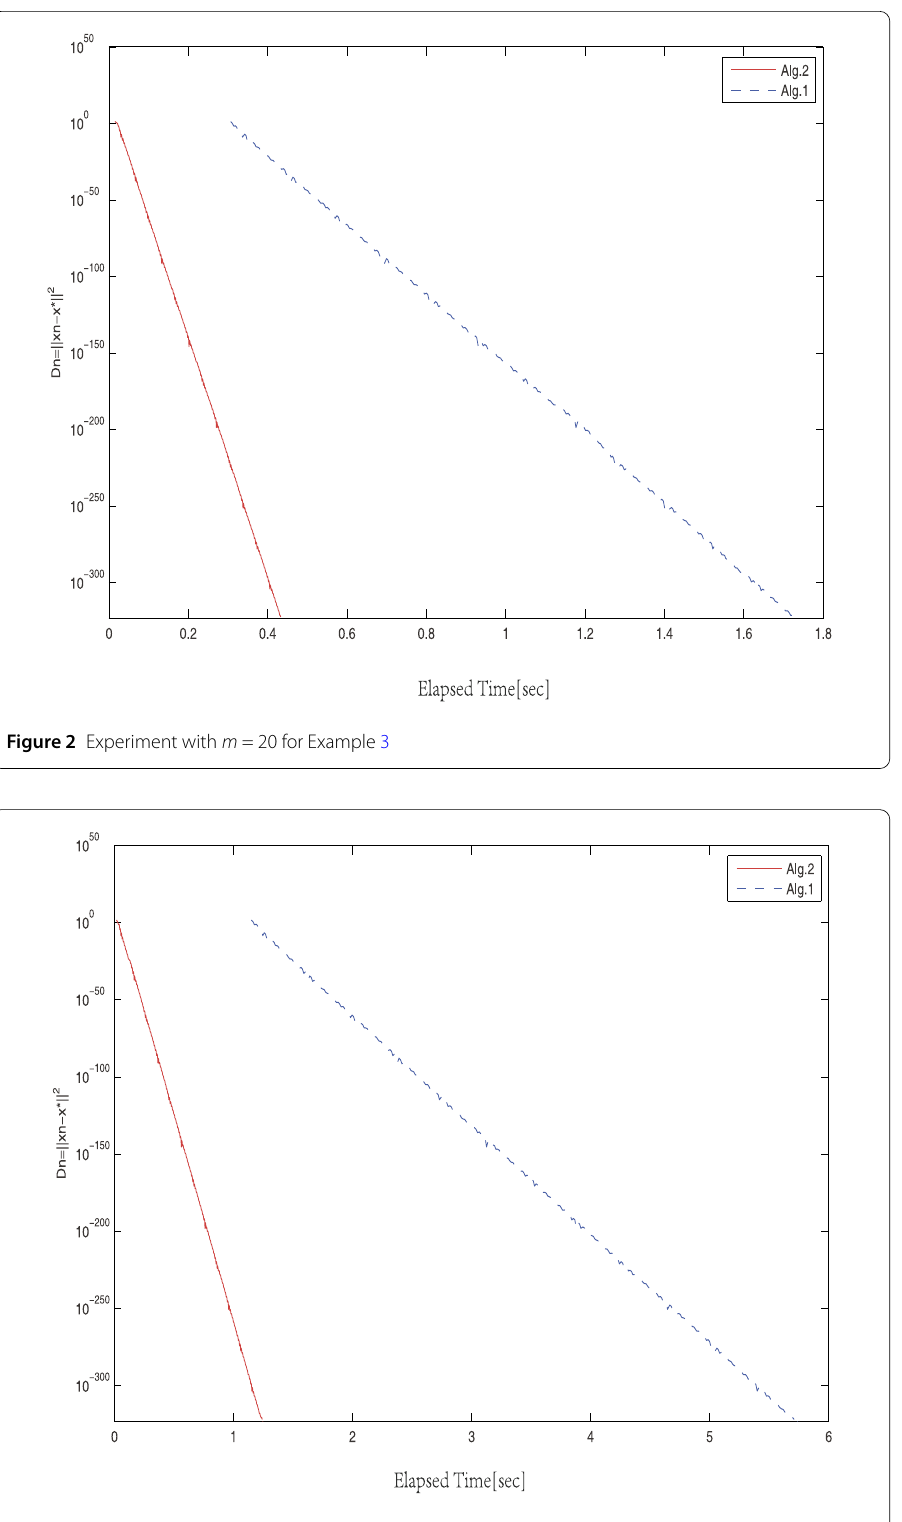
Figure 3 Experiment with m = 50 for Example